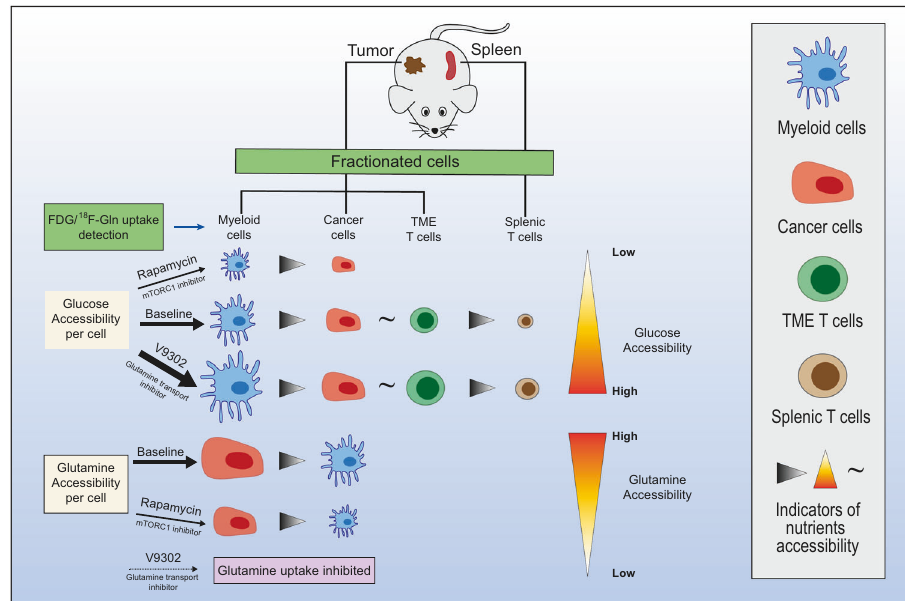
Fig. 1 The mTORC1-driven metabolic reprogramming of distinct cell populations in TME. On the baseline level, the myeloid cells exhibit the greatest glucose uptake, followed by cancer cells and T cells in TME; while the cancer cells have the highest glutamine uptake level. All the cell populations in TME show higher nutrient uptake level than the normal splenic T cells. The inhibition of mTORC1 by rapamycin decreases the uptake of glucose and glutamine in all cell populations, and the blockade of glutamine transport induces upregulation of glucose uptake which might induce competition for glucose and reversal of immune suppression. The width of arrows, size of the cells, and the direction of the triangles represent the nutrient uptake accessibility (from high to low). The symbol “ ~ ” represents similar nutrient